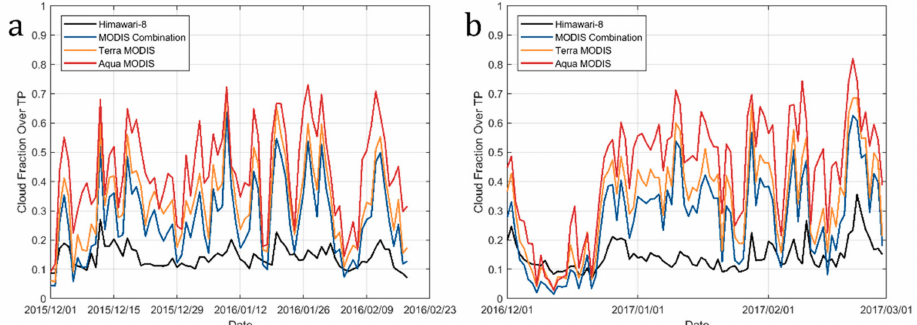
Figure 13. The Tibetan Plateau’s cloud coverage fraction from Himawari–8 AHI and MODIS in the winter season of 2015 / 2016 ( a ) and 2016 / 2017 ( b